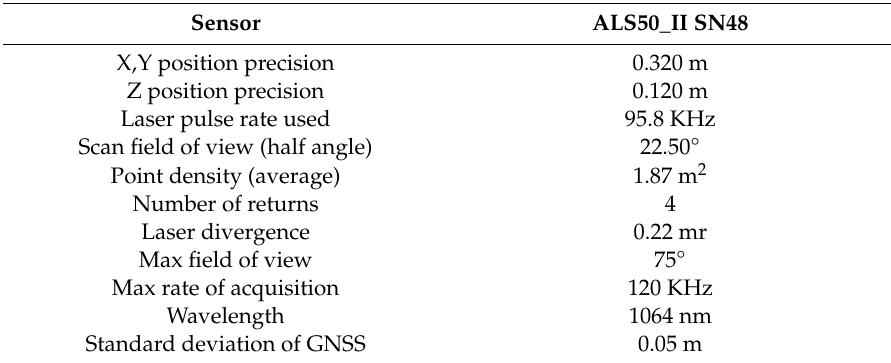
Figure 1. ( a ) Tests bed sites used in the analysis (in red), from left to right: urban (building), infrastructure (road) and natural (hillside). ( b ) point cloud image from airborne laser scanner (ALS). Table 2. Technical characteristics of the LIDAR system.